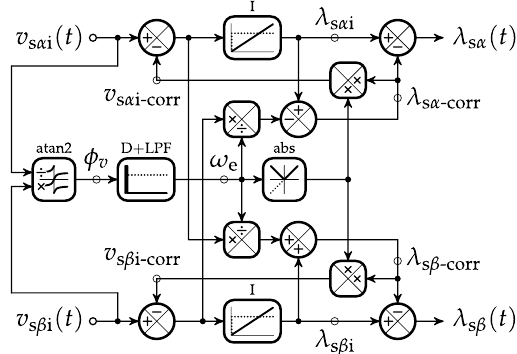
Figure 3. A block diagram of the proposed compensation of the integrational drift in the time